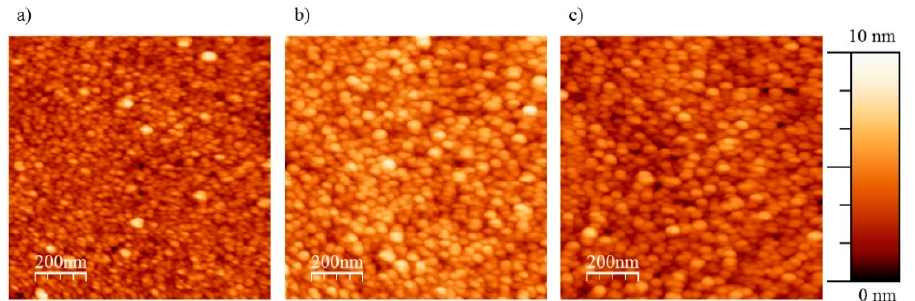
Figure 4. ( a ) AFM amplitude plot for Film 2 annealed, ( b ) Film 3 unannealed and ( c ) Film 3 annealed.